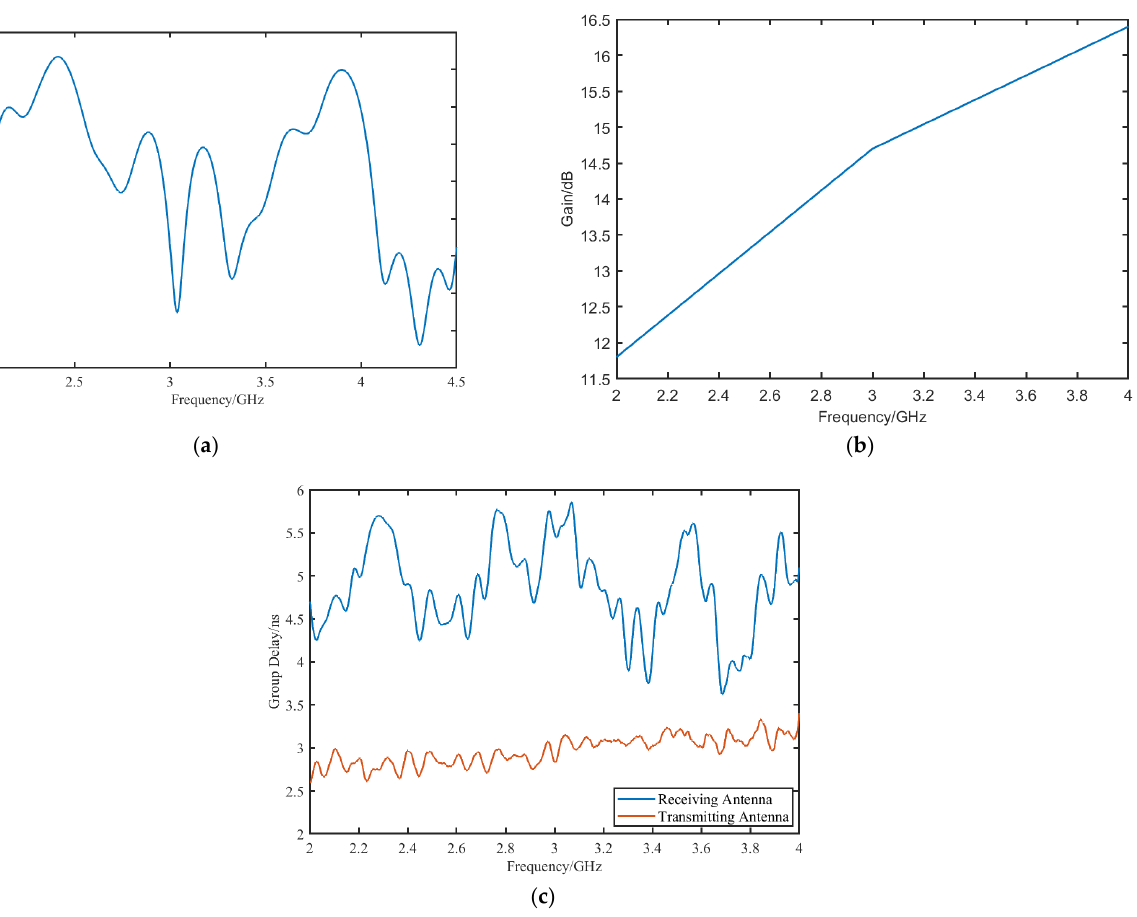
Figure 9. ( a ) Return loss of the simulated 8-element Vivaldi array antenna. ( b ) The gain of the simulated 8-element Vivaldi array antenna. ( c ) Group delay profile of the proposed transmitting antenna and the receiving array antenna.